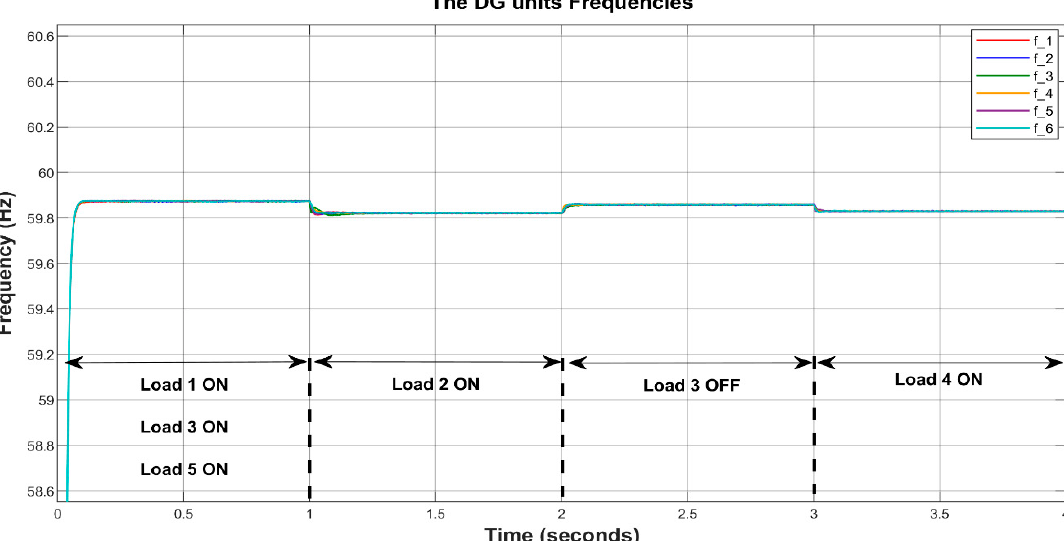
Figure 14. The DG units’ active powers for Case 2. The difference here is that the leaderless consensus control improves the current regulations, as shown in Figure 16. By comparing Figures 12 and 16 in case 1, it can be seen that the leaderless consensus control successfully removes the current differences that provide an enhancement in reactive power sharing, as in Figure 17. It is obvious that adding consensus control to the proposed